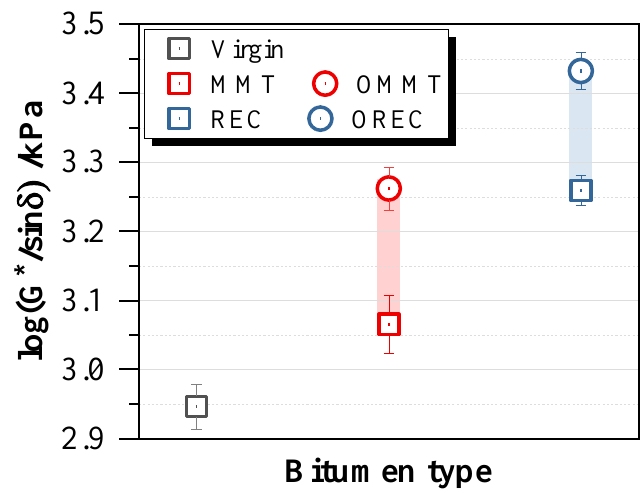
Figure 6. The G* / sin δ result at 64 ◦ C for bitumen Figure 6. The G*/sinδ result at 64  C for bitumen specimens.